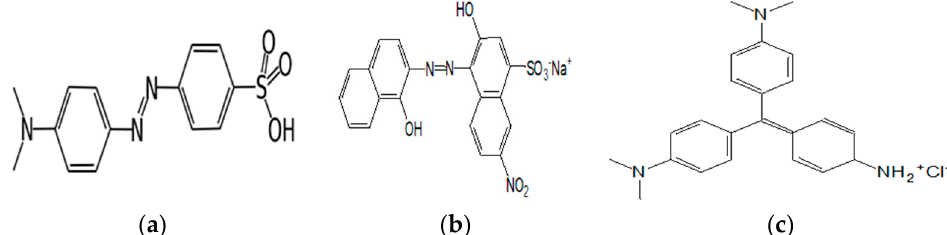
Figure 1. Chemical structure of ( a ) Hélianthin, ( b ) Eriochrom black T, ( c ) methyl